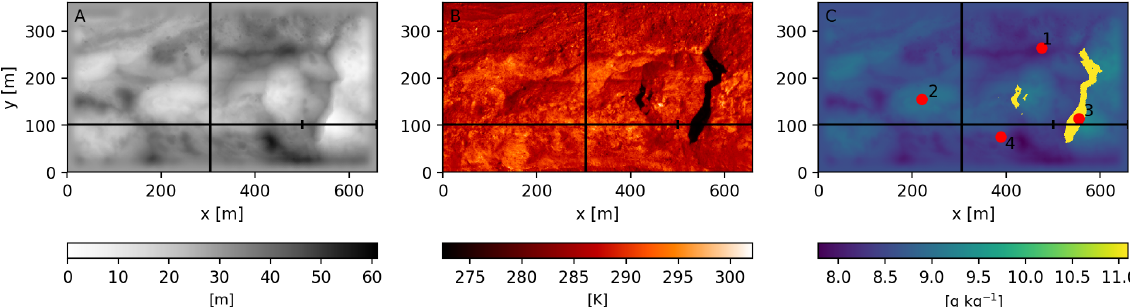
Figure 2. Boundary conditions used in MicroHH: the DEM (a) , surface temperature (b) and surface specific humidity (c) . Black lines (a–c) indicate the locations of the vertical cross sections used in Figs. 5–7. The vertical cross section used in Fig. 9 is a subset of the cross section ( x = 500–660, y = 102). Its start and end points are indicated by small vertical lines. Red points indicate the locations used in Fig. 8 (1: dry debris; 2: wet debris; 3: ice cliff; 4: